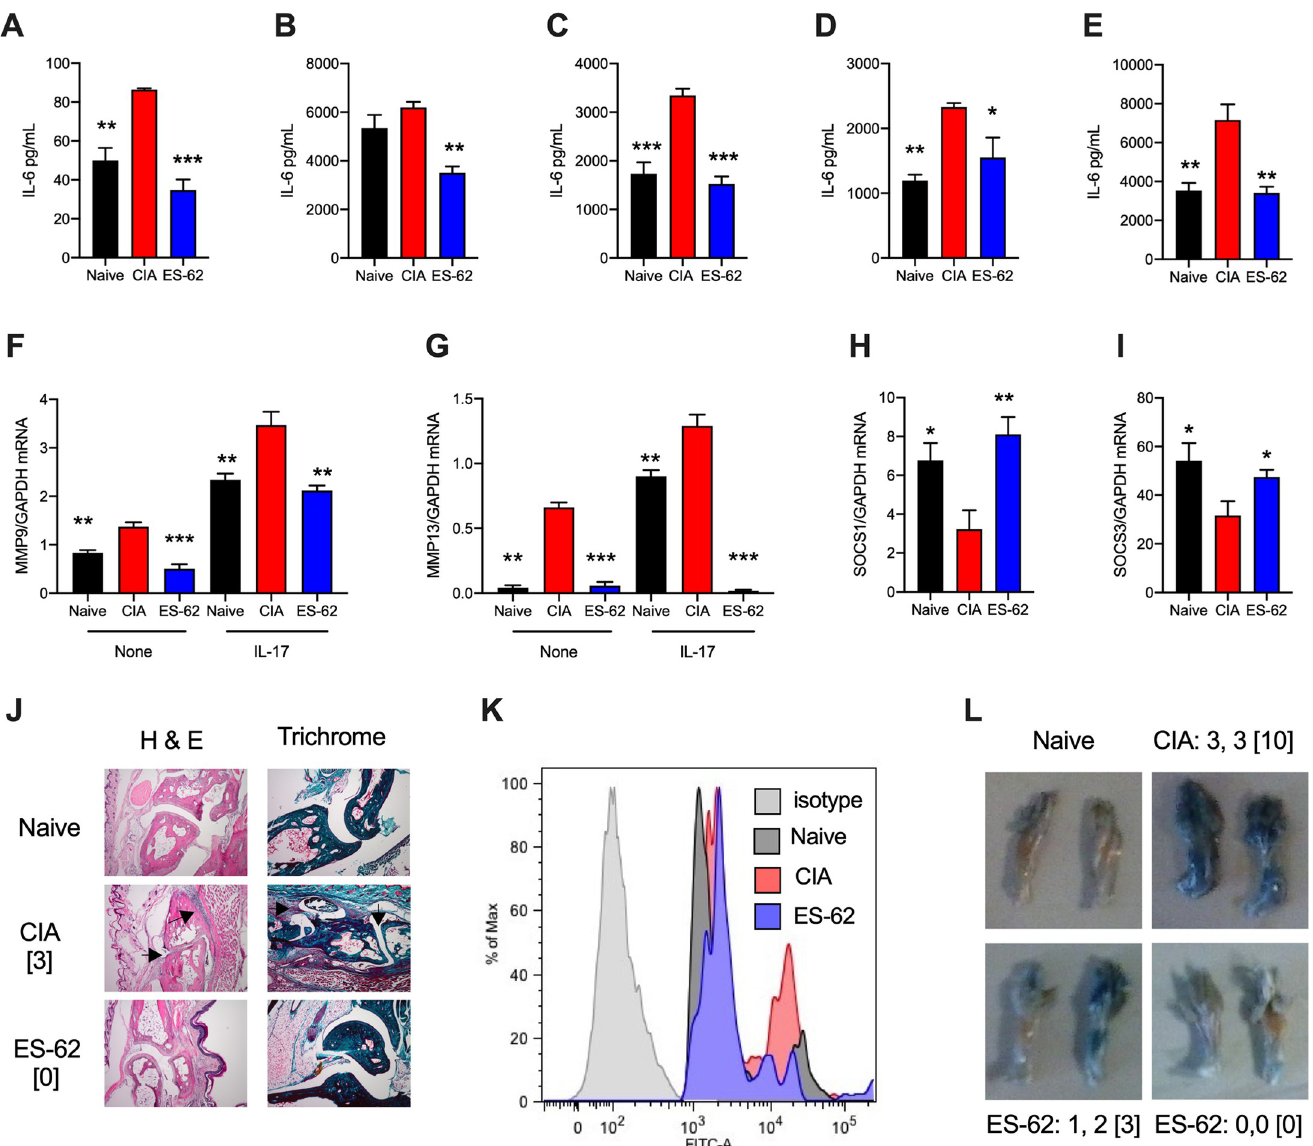
Fig 1. CIA induces a “hyper-responsive” SF phenotype that is counteracted by ES-62. SFs from Na ï ve, CIA and ES-62-CIA (ES-62) mice were incubated overnight in ( A ) medium or medium containing ( B ) IL-17, ( C ) IL-1 β , ( D ) LPS or ( E ) BLP, and IL-6 release measured. Data are mean (of means of triplicates) values ± SEM of n = 3 cultures representative of 3–7 cultures. The pooled data revealed that CIA-SFs showed 1.486 ± 0.180-fold (n = 7, p < 0.05) and ES-62-SFs, 0.873 ± 0.099-fold (n = 4) basal IL-6 release relative to Na ï ve-SFs and IL-17-stimulated CIA-SFs exhibited x2.29 ± 0.57-fold (n = 3, p < 0.05) release compared to Na ï ve-IL-17 controls, whilst treatment with ES-62 reduced this hyper-production (x 1.87 ± 0.62-fold, n = 3). SFs were analysed for mRNA levels of MMP9 and MMP13 ( F and G ) or for SOCS1 and SOCS3 ( H and I ), following incubation overnight in medium (None) or where indicated, medium containing IL-17. Data are from single experiments representative of at least two and presented as mean (of means of triplicates) values ± SEM of n = 3 cultures, assayed by qRT-PCR. ( J ) Joint pathology showing representative sections from mice, with articular scores of the joint examined [indicated]. Arrows show the cartilage erosion and cellular infiltration in CIA sections. ( K ) Flow cytometric analysis of the hypoxic status of joint SFs determined by pimonidazole in vivo . ( L) Representative images of joint vascular leakage (Evan’s Blue), where articular score for individual paws and [total mouse score] are from one experiment representative of two independent models. Throughout, SFs were pooled from individual mice to generate representative explant cohorts with articular scores: ( A-E, and I ) CIA, 3.17 ± 1.38, n = 6; ES-62, 0.5 ± 0.22, n = 6; ( F-H) CIA, 3.66 ± 1.5, n = 6; ES-62, 1.5 ± 1.15, n = 6; ( K ) CIA, 4.667 ± 1.99, n = 6; ES-62, 0.8 ± 0.8, n = 5. In all panels, � p < 0.05; �� p < 0.01; ��� p < 0.001 relative to CIA SFs.